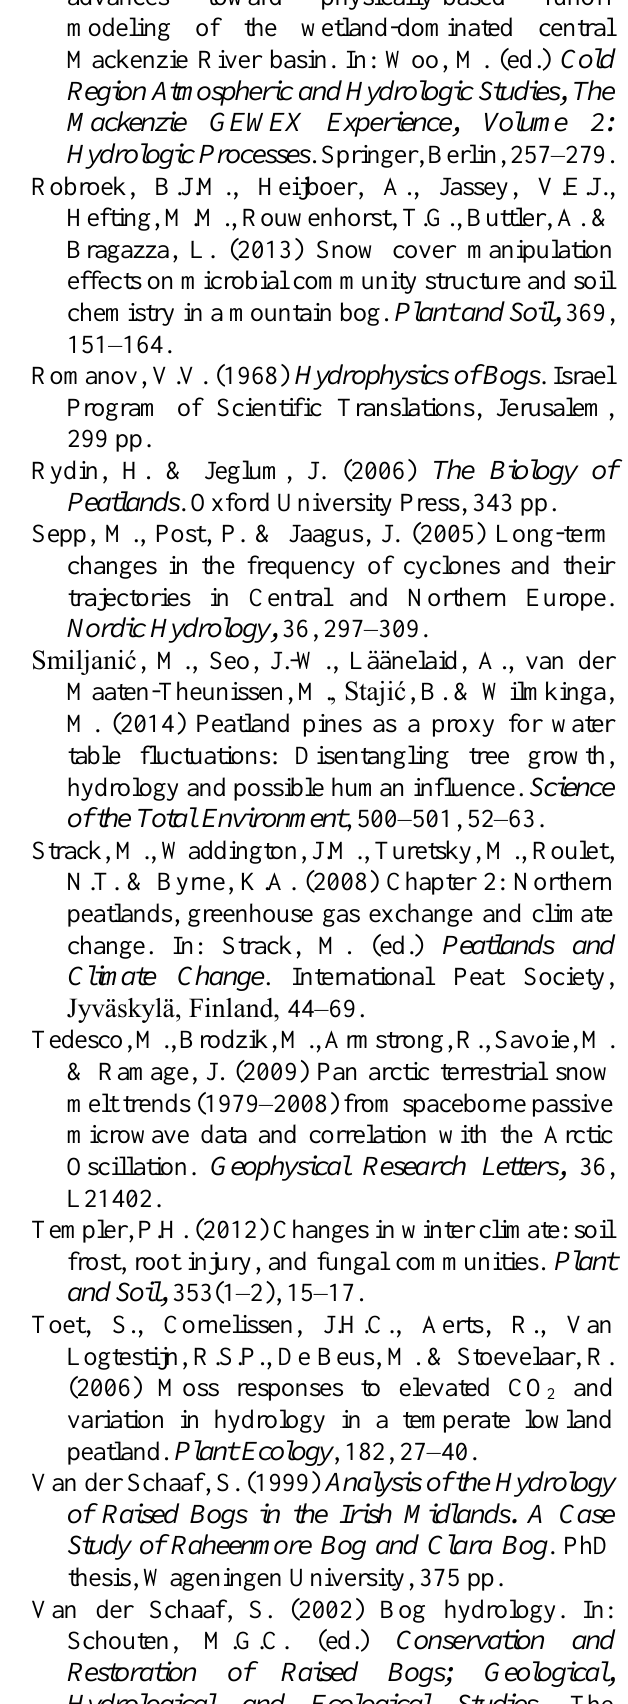
table fluctuations: Disentangling tree